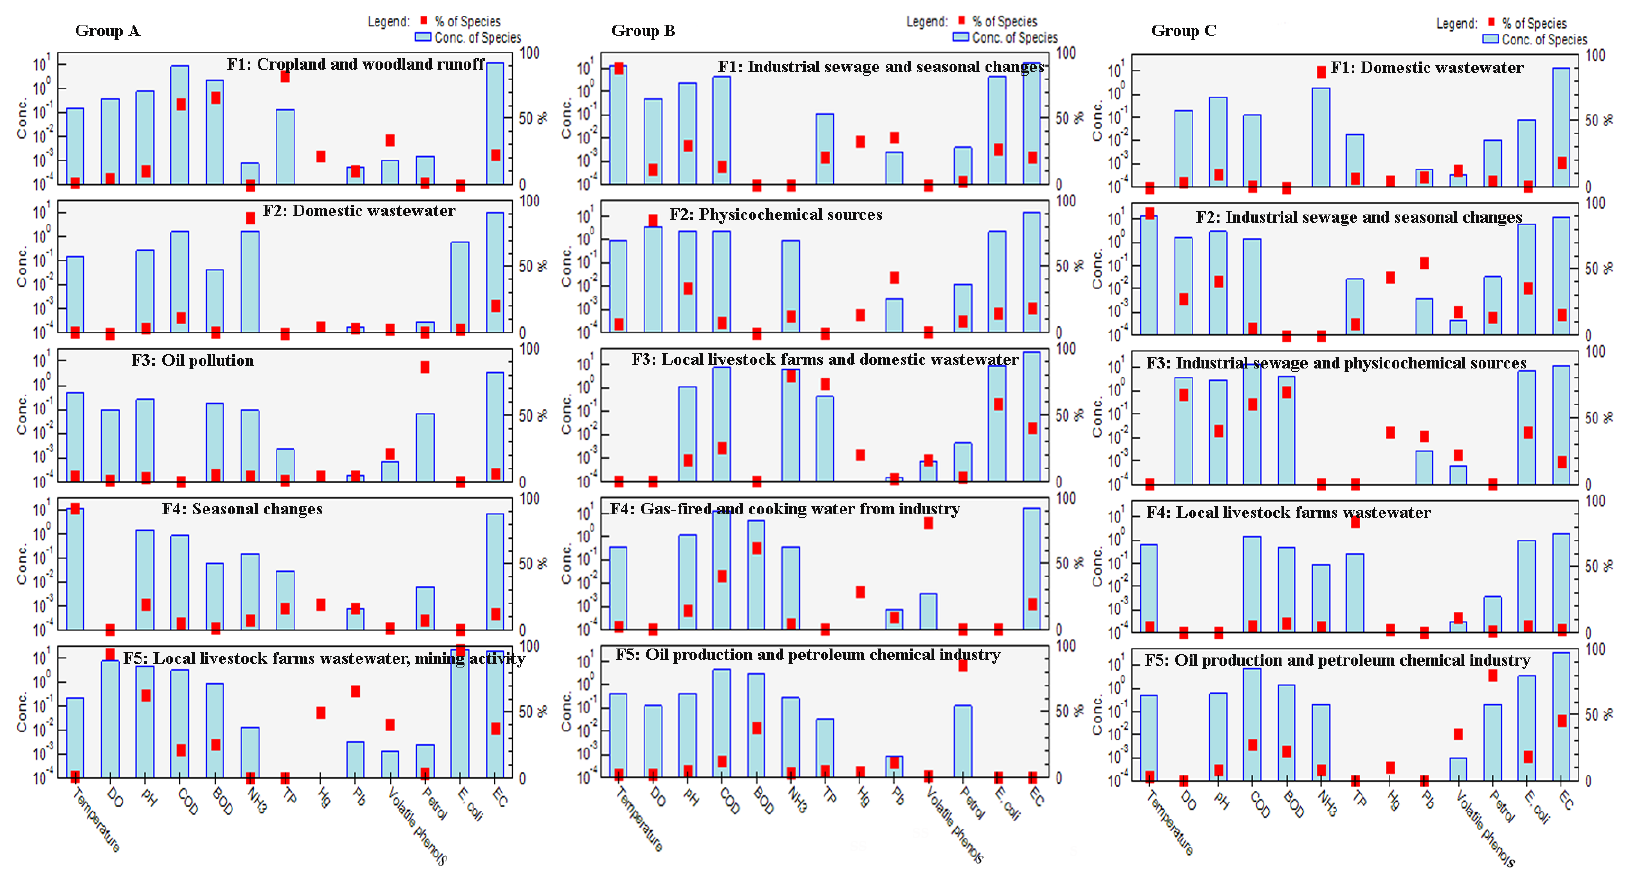
Figure 9. Comparison of factor profiles between the concentration of species and the percentage of species by PMF (Positive Matrix Factorization) for group A , group B and group C .